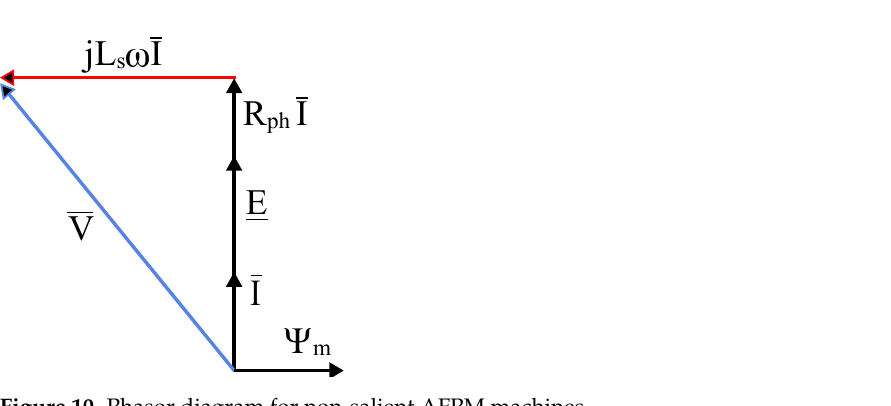
Figure 10. Phasor diagram for non-salient AFPM machines.